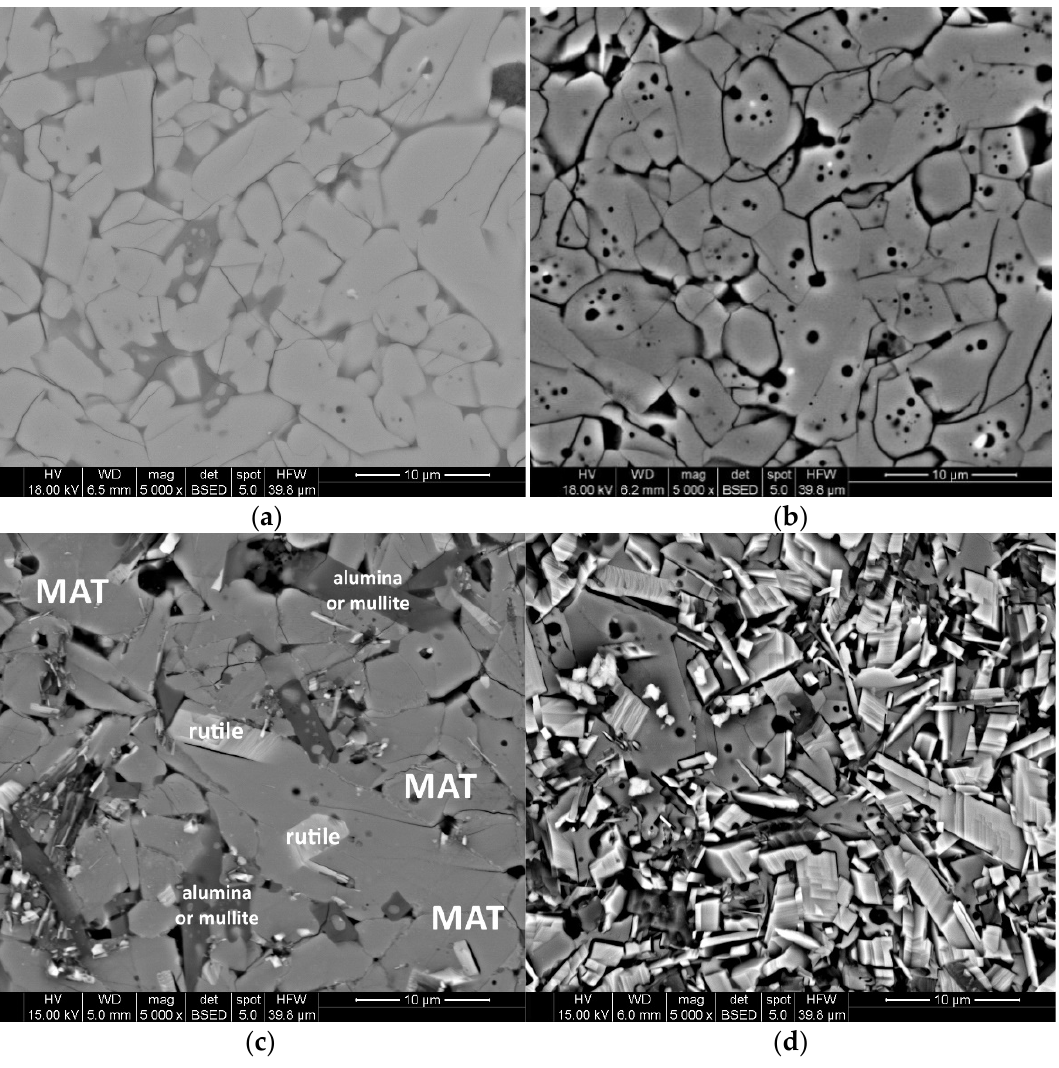
Figure 10. Effect of annealing of MAT solid solutions on the evolution of their microstructure. ( a ) AT 18MT 4S. ( b ) AT 4M. ( c ) AT 18MT 4S_1100 °C/96 h. ( d ) AT 4M_1100 °C/96 h.